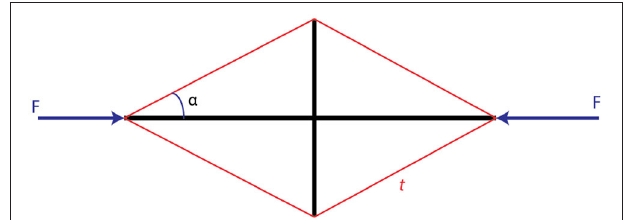
TABLE 2 | Mass of the D-Bar satisfying K